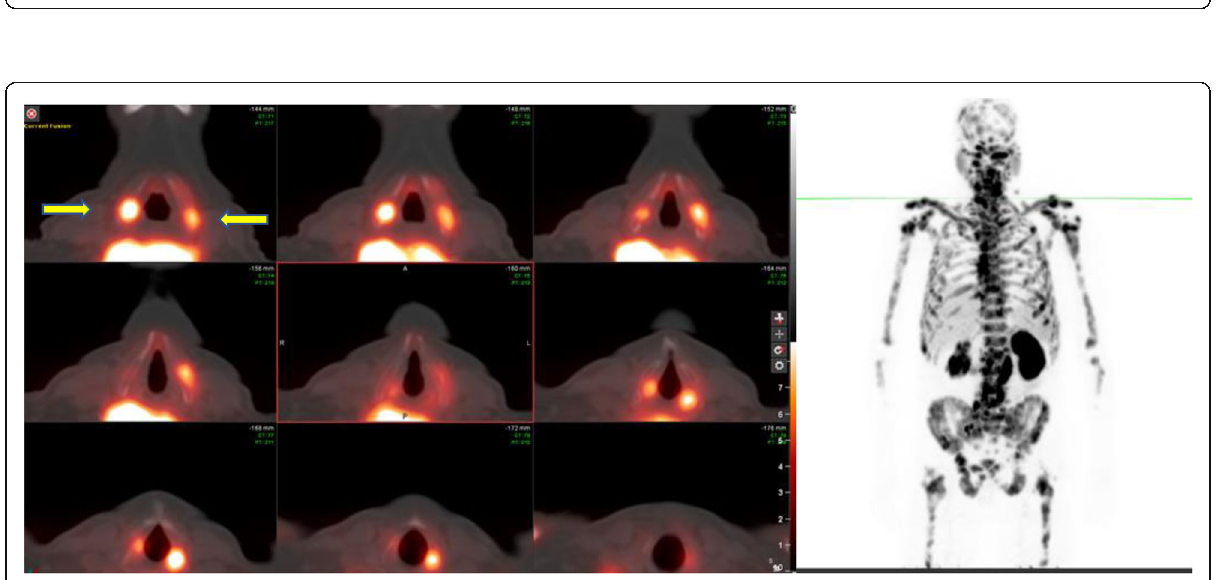
Fig. 2 68 Ga-PSMA-11 PET/CT scan images (CT image above, PET image in the middle, and fused images below) of a 59-year-old man with castrate-resistant metastatic prostate cancer. The PSA at the time of the scan was 11.1 ng/ml. The axial, sagittal, and coronal images of the neck show a 68 Ga-PSMA-11 avid lesion with an SUV = 3 (arrows) in the right side of the thyroid cartilage. The MIP whole-body image depicts other progressive metastatic lesions